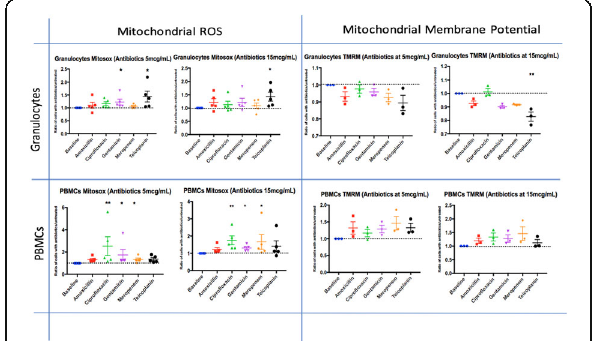
Fig. 1 (abstract 001670). See text for